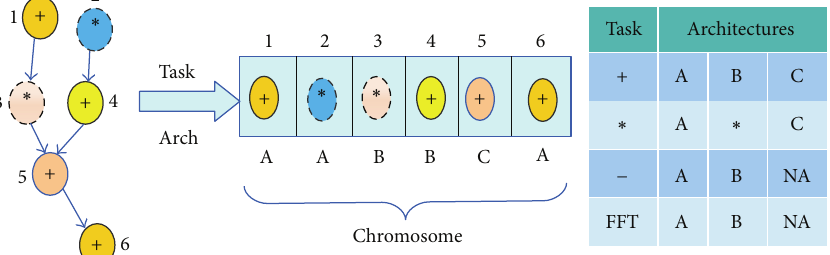
Figure 8: A Single Island GA module.